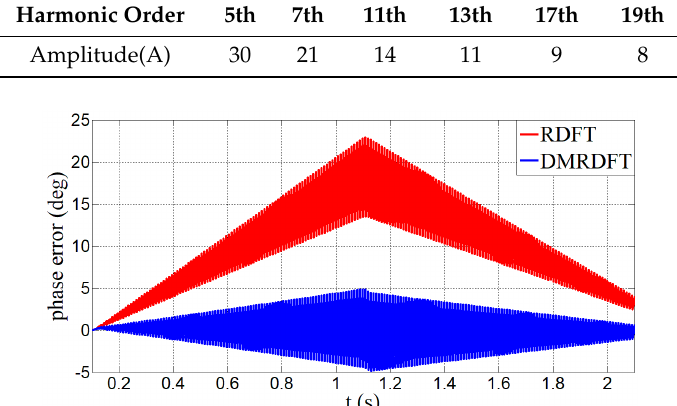
Figure 11. Dynamic phase effect on the 17th harmonic detection.